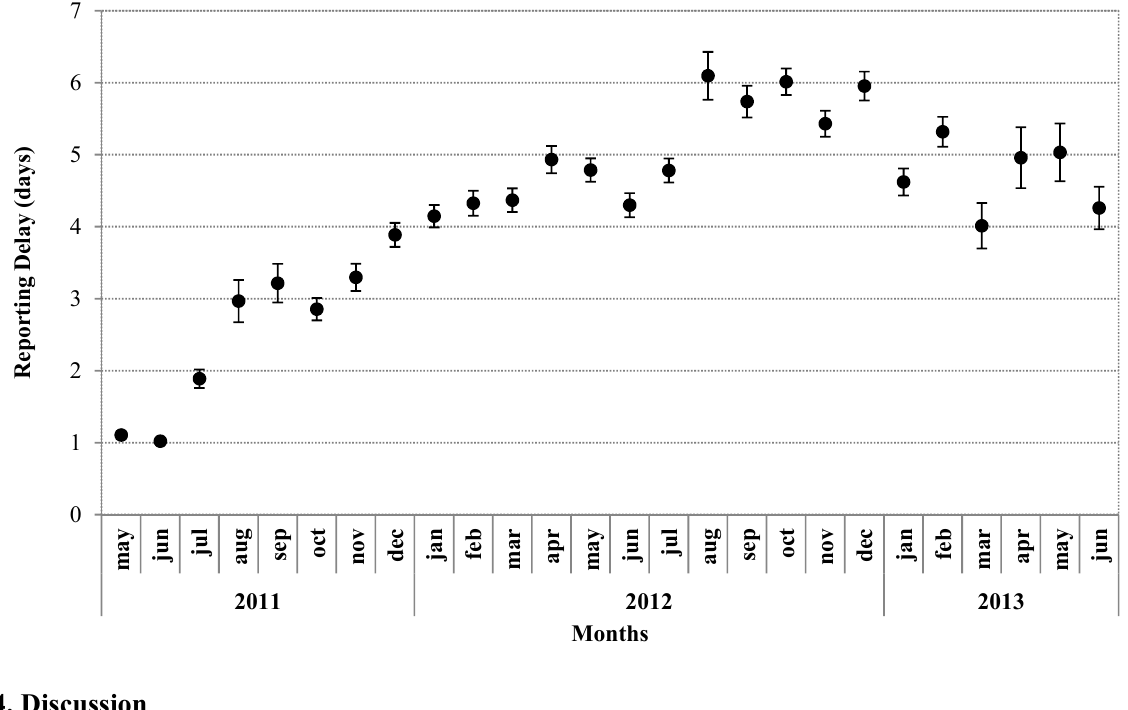
Figure 3. Timeliness of the syndromic surveillance system expressed as the mean delay per month in days and confidence interval (95% CI), 1 May 2011–30 June